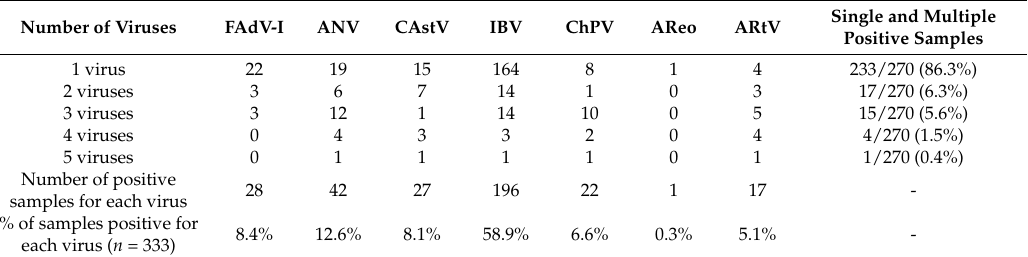
Table 2. Frequencies of single and multiple viral infections diagnosed in 270 samples.